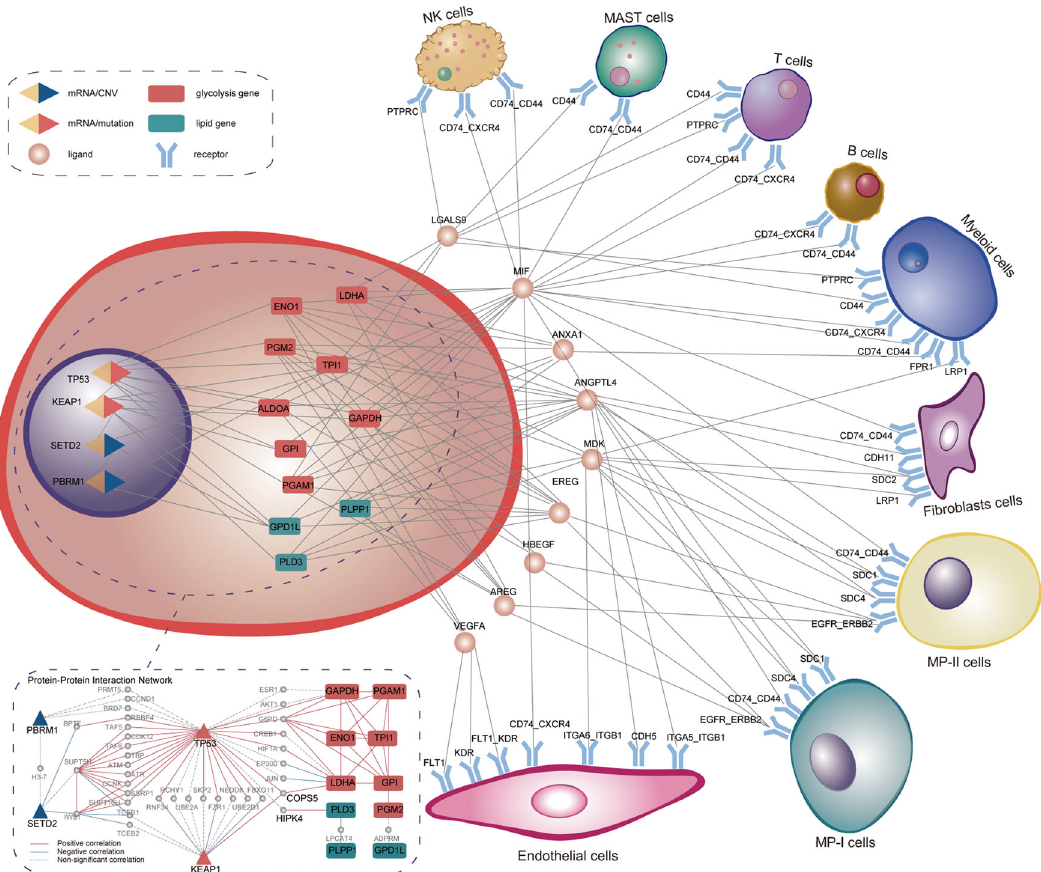
Fig. 8 Comprehensive network linking the intracellular oncogenic and metabolic events of MP-III with intercellular communications. The correlation network includes four genetic events ( TP53 mutation, KEAP1 mutation, SETD2 deletion, and PBRM1 deletion), the 11 metabolic genes, and 45 ligand – receptor pairs of MP-III interacting with other cells in the tumor microenvironment. Here, the interacting genes expressed on MP-III were restricted to the nine ligands that were signi fi cantly upregulated in MP-III compared to MP-I. The nodes represent these genes and the edges represent the signi fi cant correlation between two nodes in the TCGA dataset (Pearson correlation, FDR < 0.05). The dotted box is the protein – protein interaction network between genetic events and the 11 metabolic genes from the STRING database, within the solid lines, represent signi fi cant correlation (Pearson correlation, P <